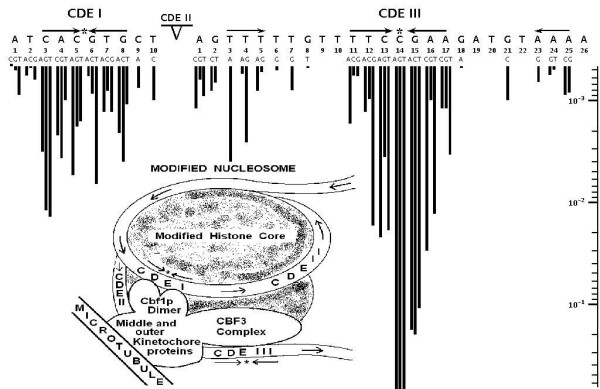
CDEI & CDEIII sequences, their associated mutant's chromosome loss rates, and approximate locations of the DNA-protein components in a centromere nucleosome model. At the top the three main conserved wild type DNA sequences, CDEI, CDEII, and CDEIII are represented. The core palindromes are marked by bold arrows and the symmetry centers by asterisks. The flanking palindrome areas of CDEIII are indicated by lighter arrows. Below each of the wild type sequences, the different mutant bases tested for each wild type base position are shown. Beneath each mutant, the bold vertical line indicates it's relative loge (loss) rate, of magnitude indicated by the log scale shown. These data are recreated from Hegemann et al [7] Figure 3. The inset depicts a model of the yeast centromere showing the modified nucleosome formed by wrapping the CDEI site into close proximity to CDEIII. Also shown are their associated protein complexes that along with additional binding proteins form the kinetochore, which bind the spindle microtubule [2].